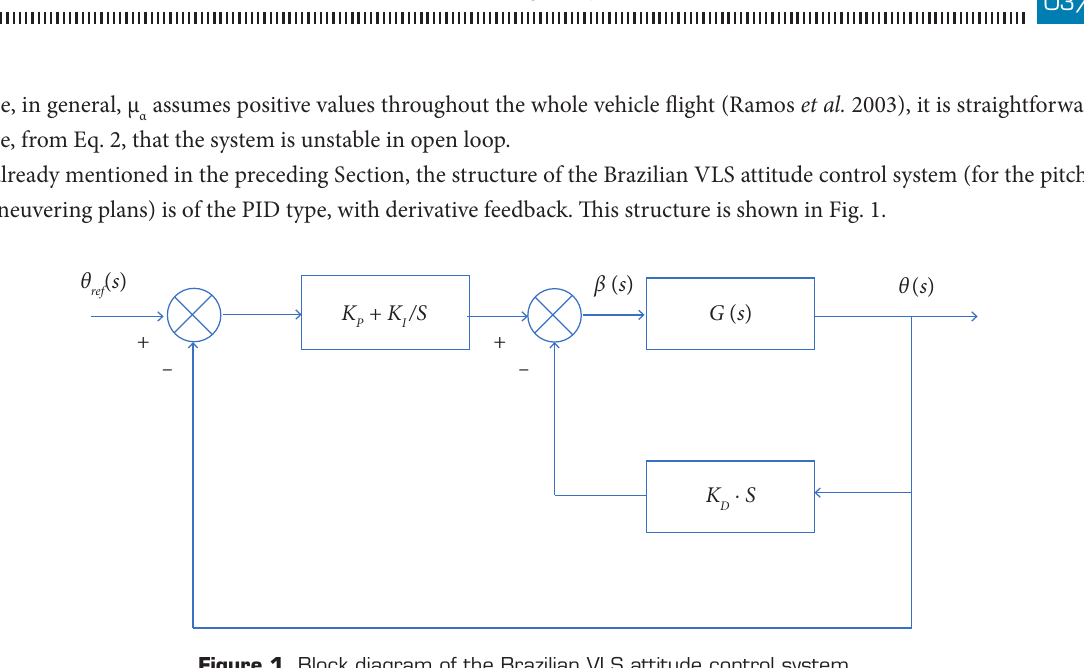
Figure 1. Block diagram of the Brazilian VLS attitude control